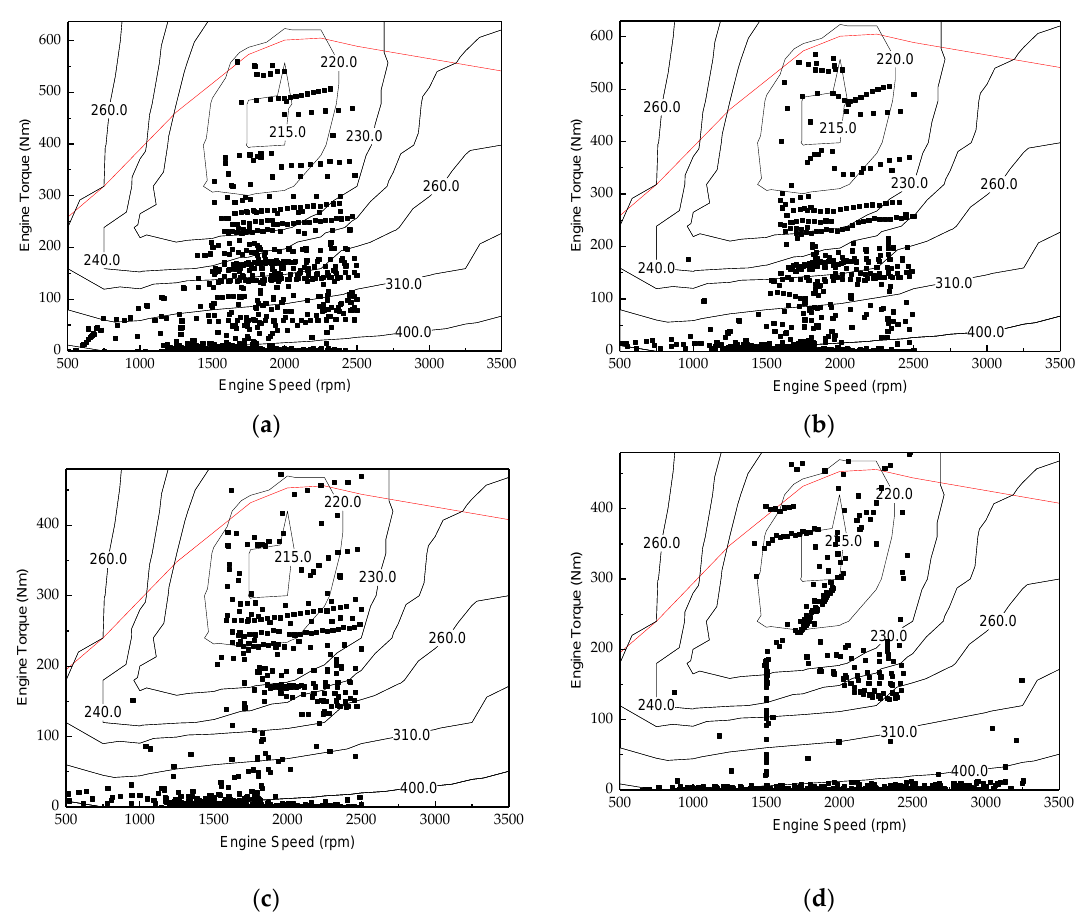
Figure 13. Engine working points of the ( a ) TV, ( b ) HHV, ( c ) HEV, and ( d ) HESV.